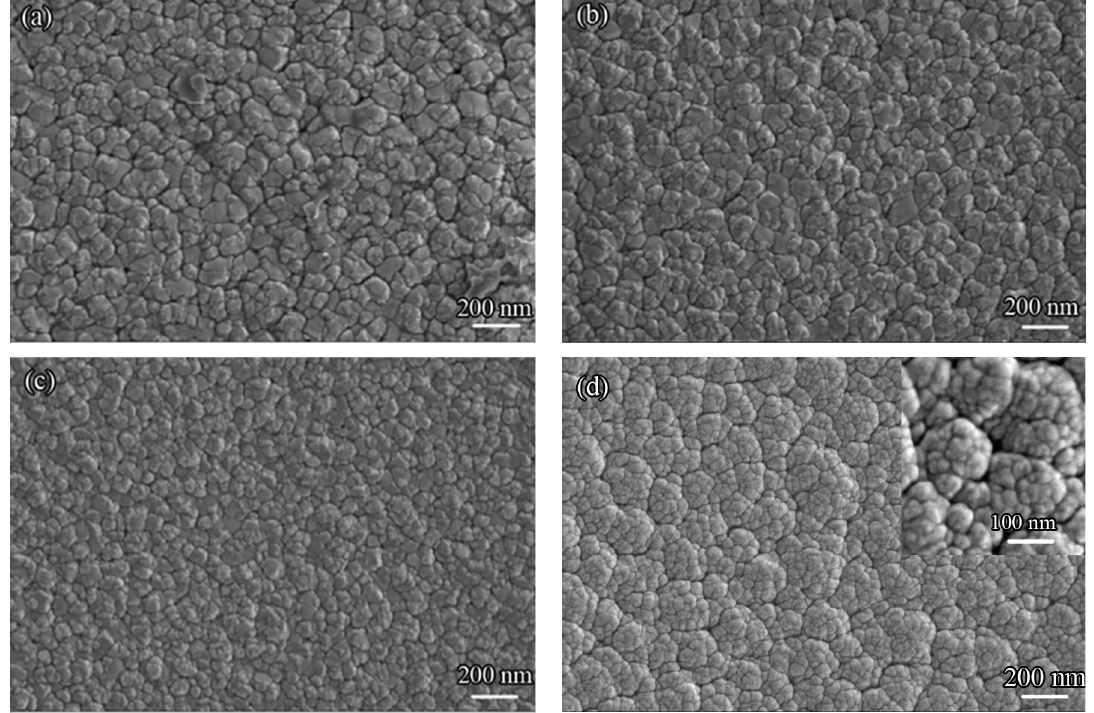
Figure 3. Surface images of the four CrAlSiN coatings deposited under different Al sputtering power ( a ) 0.6 kW ( b ) 0.8 kW ( c ) 1.0 kW and ( d ) 1.2 kW.